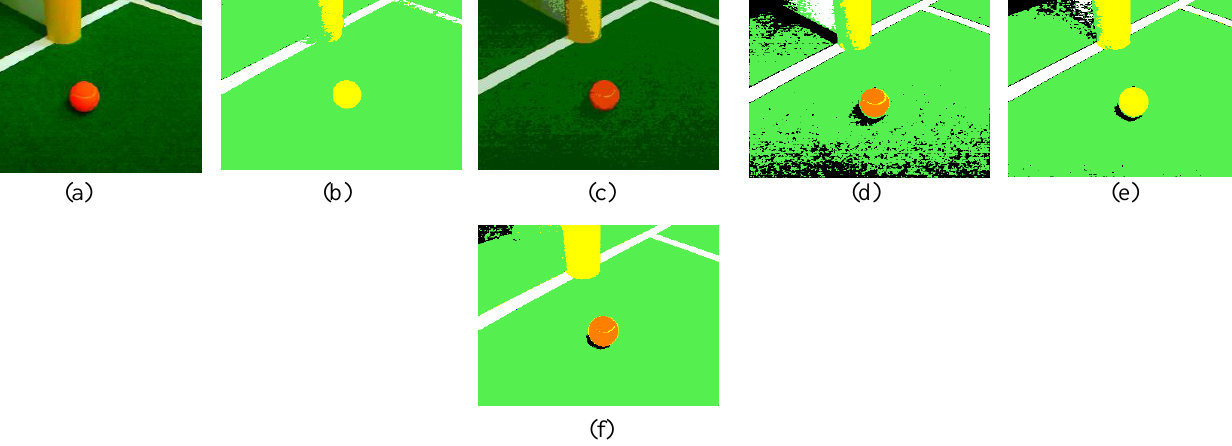
Figure 7. (a) original image, the rest are segmentation result of the test image produced by the following algorithms: (b) PSO random initialization, (c) k-mean with SVM, (d) ANFIS, (e) CLPSO random initialization, (f) proposed